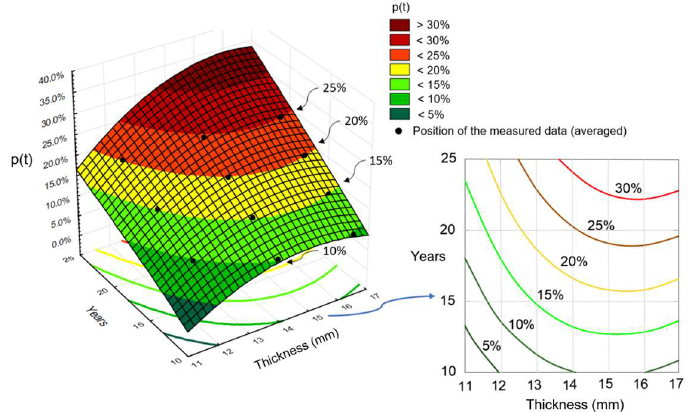
Figure 5. Corrosion depth percentage plotted against the operating time and built-in thicknesses of the LG of the bulk carriers examined. The data above show that thicker longitudinal girders reach the replacement criteria faster. For example, an LG whose thickness is 12 mm will reach a 20% of corrosion depth percentage in around 22.5 years. The limit of 25% will not be reached at all and replace- ment would not be necessary. However, an LG that is 15–16 mm thick will reach the limit of 20% in about 16 years and the limit of 25% in approximately 19 years. Figure 5 (right 2D plot) shows a range of thickness values (see 14–16 mm) whose corrosion depth is in- creasing faster than for thin plates since the requirements minima are gravitating towards such a range. These findings correspond to the conclusions from Section 3, which indicate